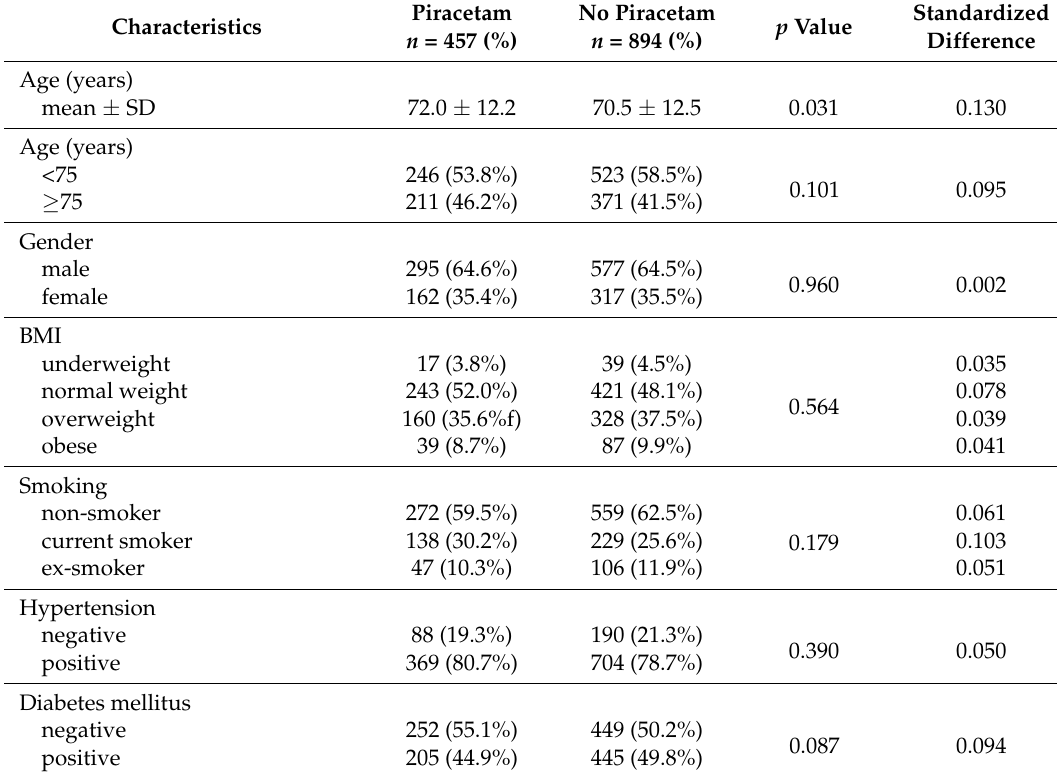
Table 1. Baseline epidemiological and comorbidity characteristics of ischemic stroke patients receiving piracetam versus those not receiving piracetam in